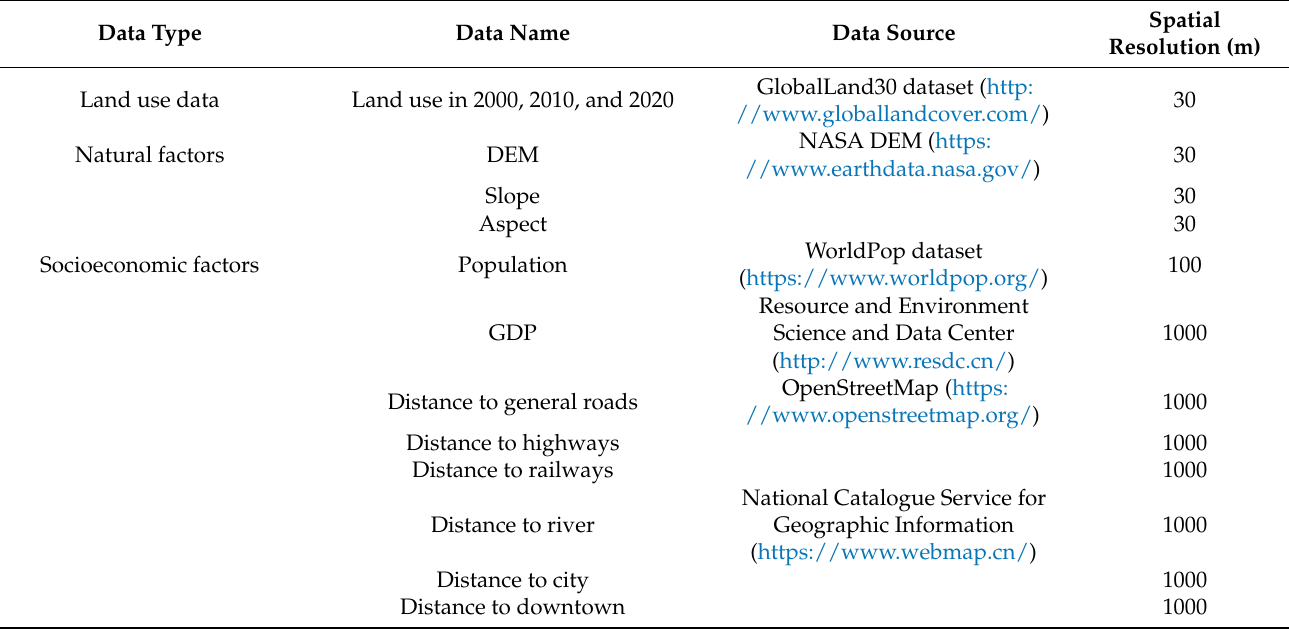
Table 1. Data sources and